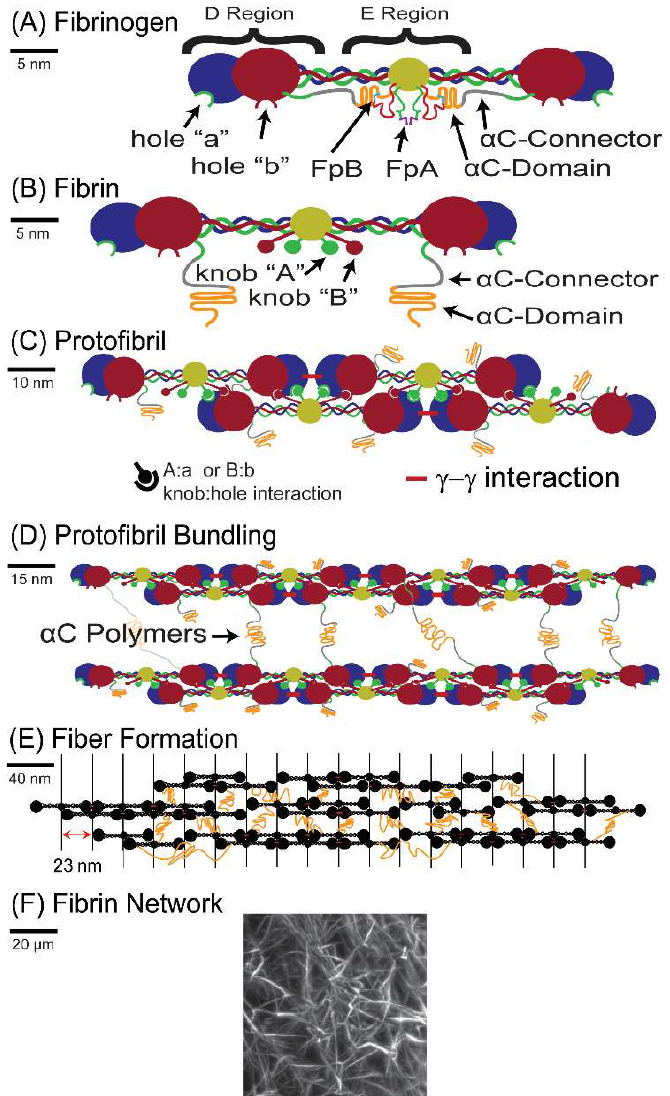
Figure 1. Schematic of the polymerization process: ( A ) Cartoon of the fibrinogen protein: the α chain is shown in green, β chain in red, and γ chain in blue; the disulfide bond-rich center of the molecule, where all six chains are connected, is depicted in yellow. ( B ) The fibrin molecule: upon thrombin cleavage of FpA and FpB, knob A and knob B are exposed to bind the respective hole a and hole b. ( C ) A half-staggered protofibril grows longitudinally as the knobs in the central region of one molecule bind to the holes in the distal region of two opposite molecules. ( D ) Lateral aggregation of protofibrils, likely mediated by interactions of the αC regions, which consist of the αC-connector and αC-domain. ( E ) Further aggregation of protofibrils into fibrin fibers. ( F ) A representative image of fibrin fibers in a gel. The image is a maximum intensity projection of a fibrin clot formed from human plasma spiked with 0.1% Alexa-488 labeled fibrinogen, imaged using a Bruker MuVi-SPIM light sheet microscope. Solid black lines on the left of each panel show the scale.